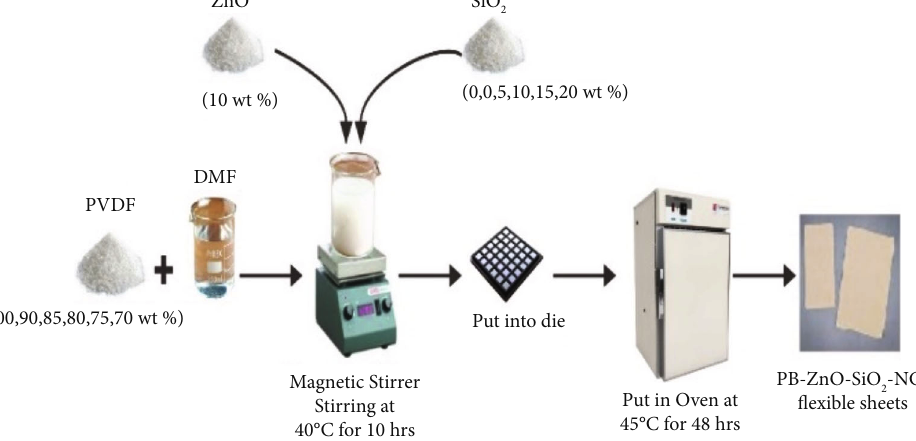
Figure 1: Schematic illustration to synthesize PVDF-based NC FSs.